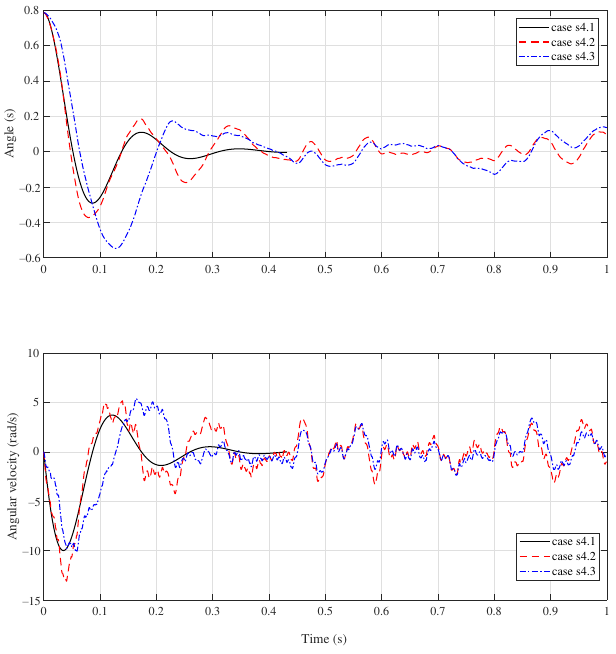
Figure 7. System response of Group s4.